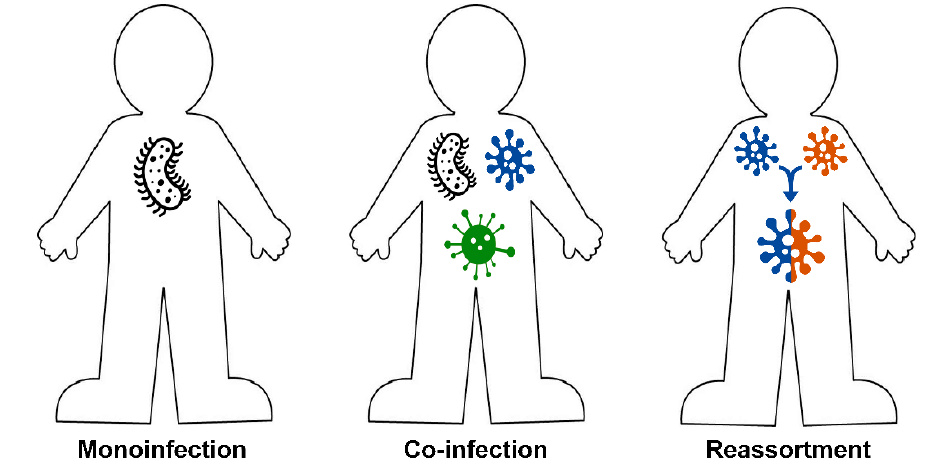
Figure 1. Host-pathogen interactions.